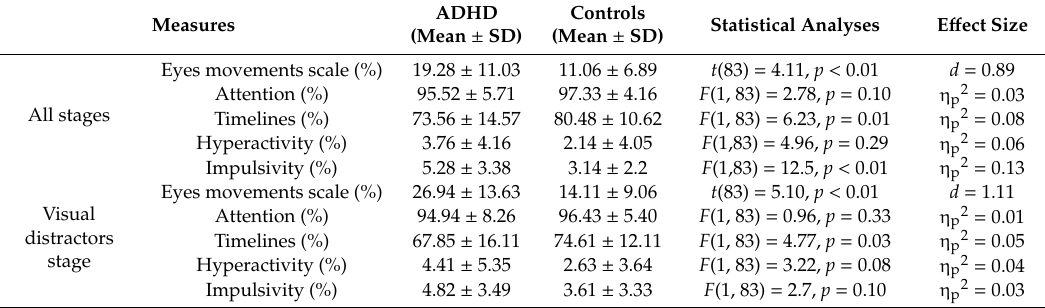
Table 2. Analyses of group di ff erences in the eye movement distractibility scale and conventional MOXO-dCPT indices, presented for the all MOXO-dCPT stages and the visual distractors stage. ADHD Controls Measures Statistical Analyses E ff ect (Mean ± SD) (Mean ± SD)